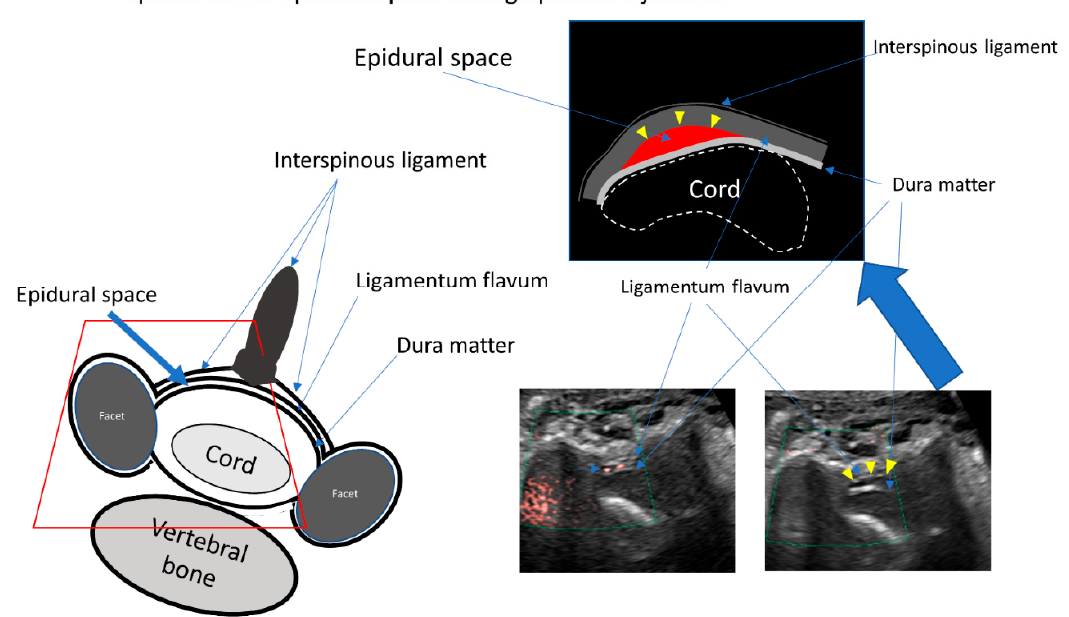
Figure 4. The illustration shows the cross section of the spinal canal. The main structures are the cord, the dura mater, the interspinous ligament, and the ligamentum flavum. The epidural space exists between the dura mater and the ligamentum flavum. The space of Okada exists between the interspinous ligament and the ligamentum flavum. Ultrasound data show the superb microvascular imaging signal during injection (left picture) and the enlargement of the epidural space after injection (upper illustration and right picture).